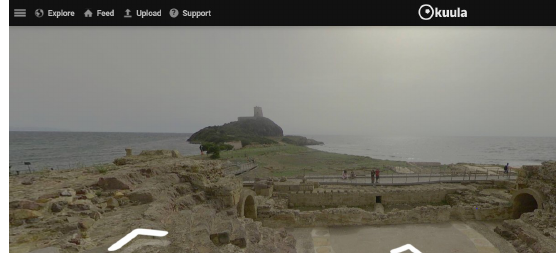
Figure 14. Viewing spot not accessible to tourists.